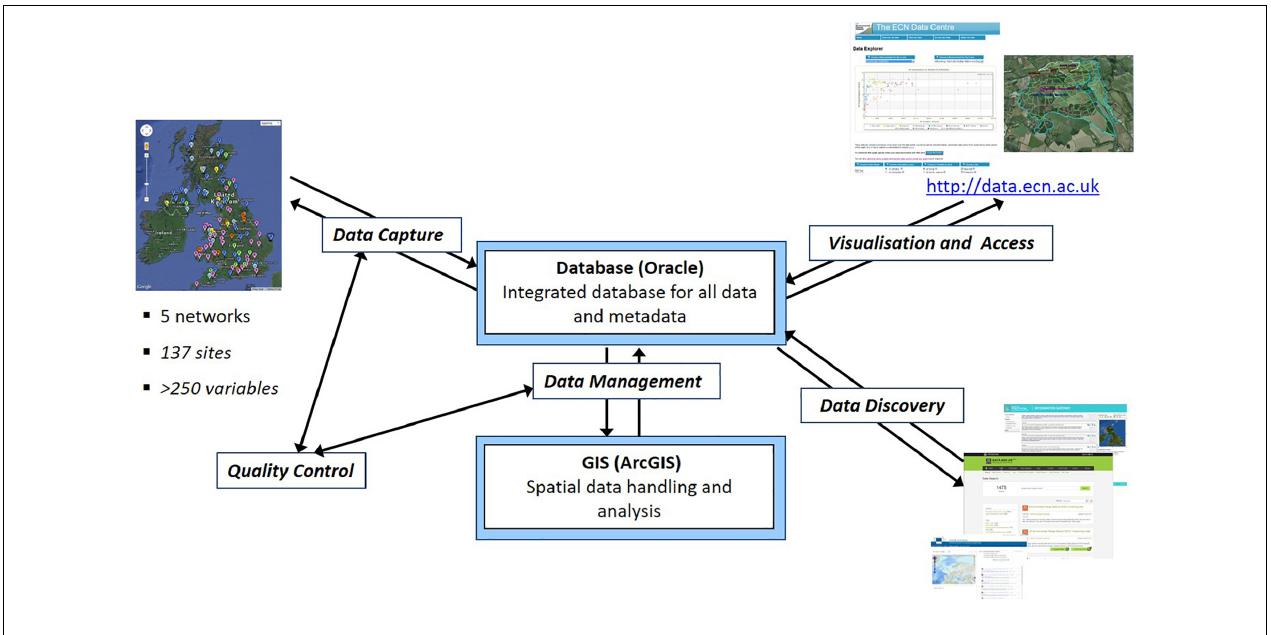
FIGURE 1 | Overview of the ECN Data Centre Information System (Rennie, 2016).